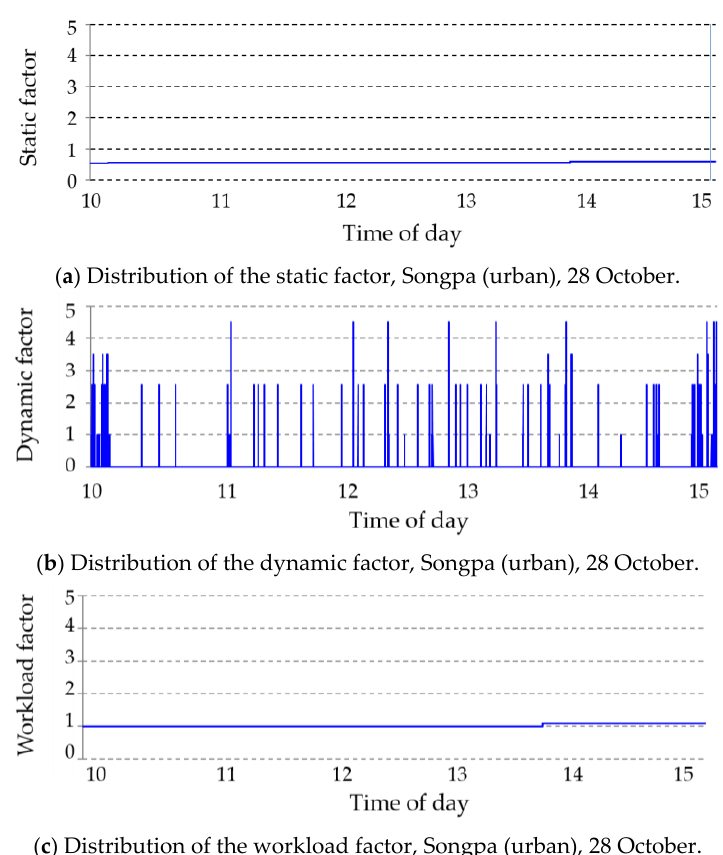
Figure 3. Distribution of a postal motorcyclist’s safety index plotted on a delivery route in Songpa over three days. Enlarged version.